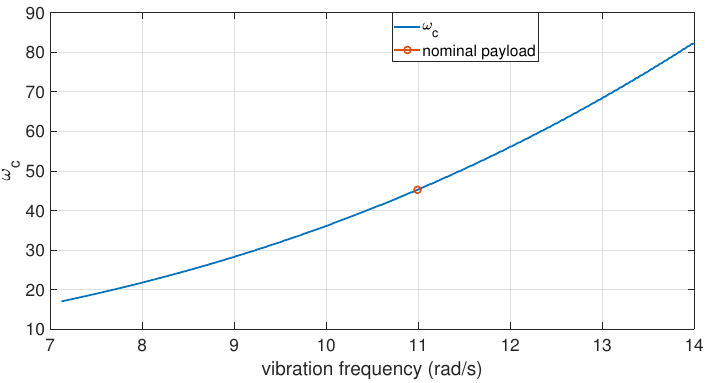
Figure 10. Gain crossover frequency versus ω using controller (43).